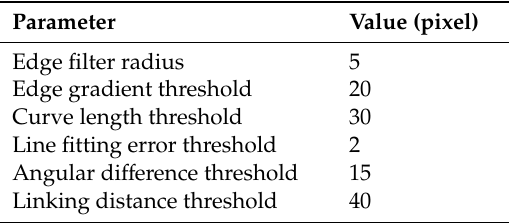
Table 5. Parameters used for the LINE extraction algorism applied to the SAR data.